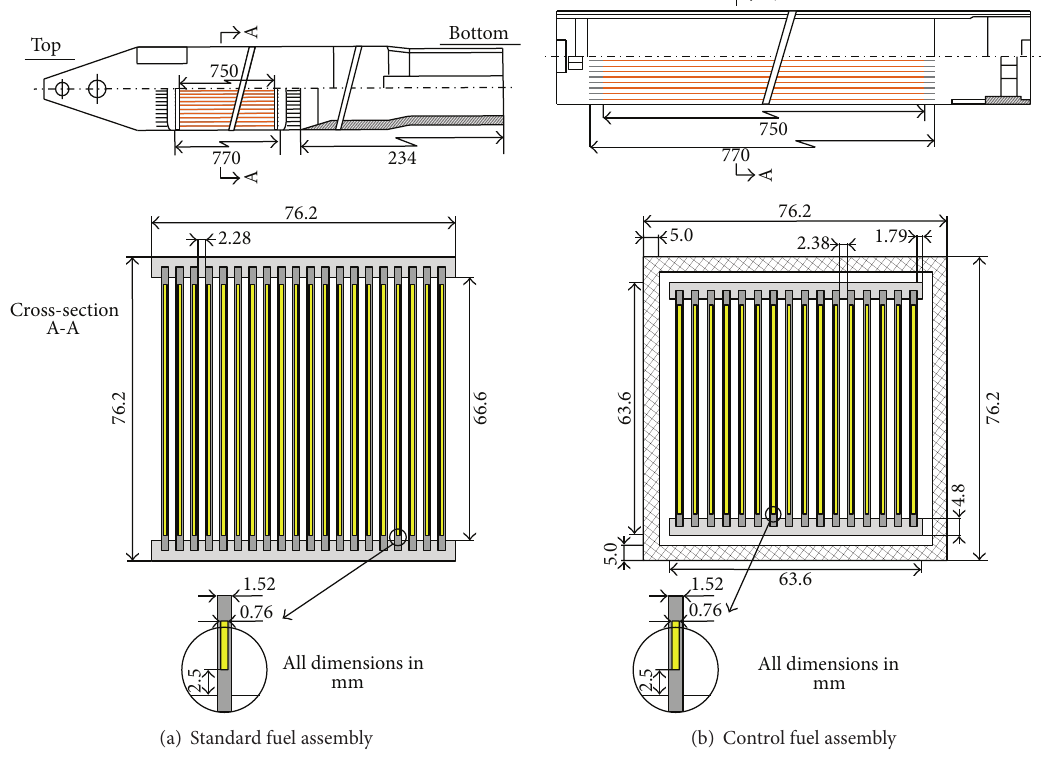
Figure 3: Schematic of fuel assemblies.